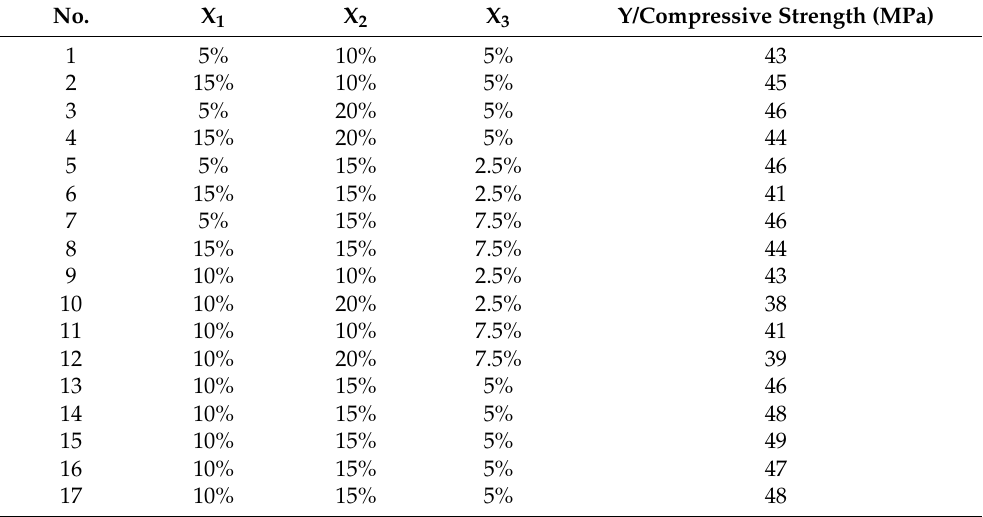
Table 5. Factors and levels of Box–Behnken experiments.